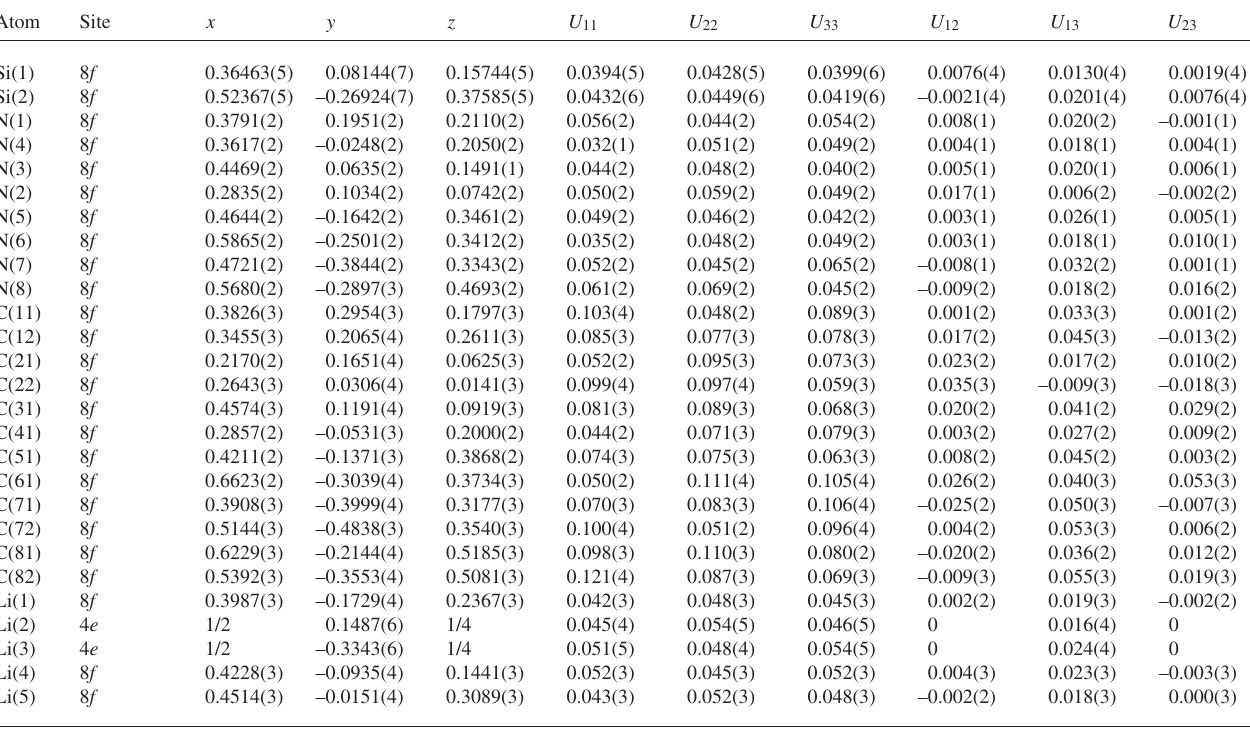
Table 3. Atomic coordinates and displacement parameters (in Å 2 )